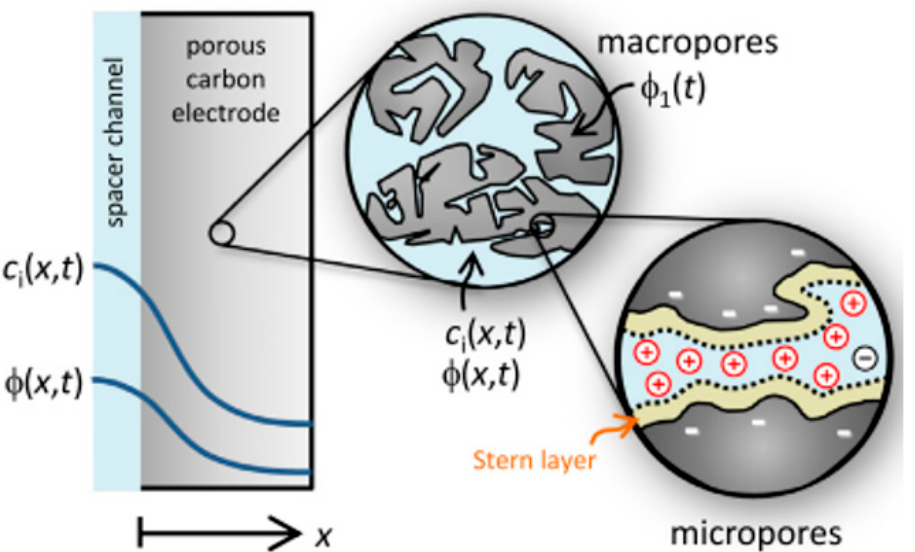
Figure 17. Donnan theory for the porous space of macro and microparticles with dual electrical layer overlap. Reprinted/adapted with permission from Ref. [34]. 2013, Porada, S.; Zhao, R.; van der Wal, A.; Presser, V. and Biesheuvel, P.M.